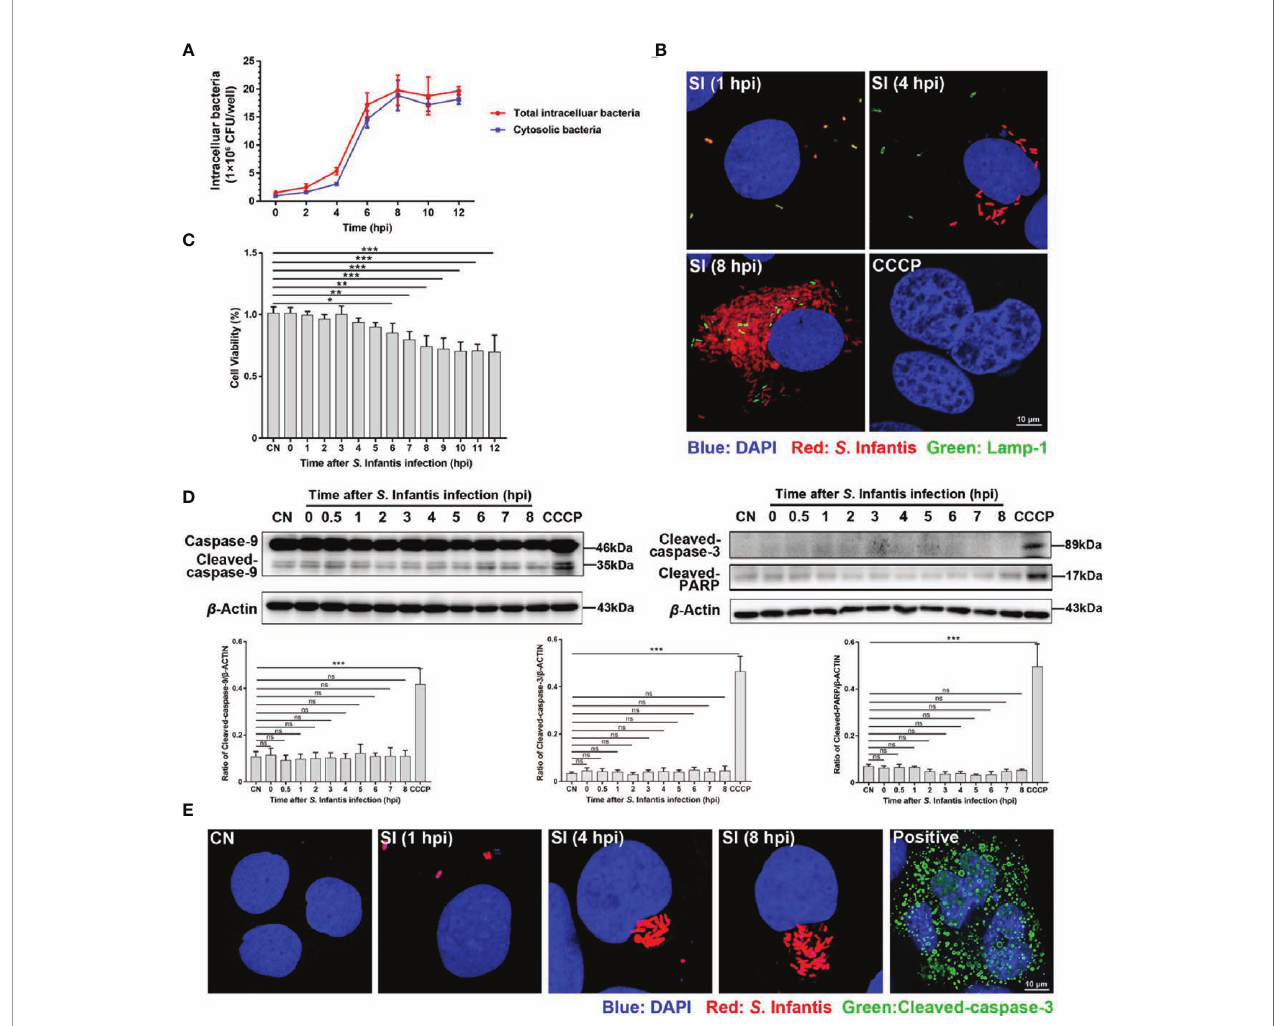
FIGURE 1 | Infected cells containing hyper-replicating cytosolic S . Infantis did not undergo apoptosis. (A) Detection of intracellular bacterial load using the gentamicin protection assay, without (total intracellular bacteria, red curve) or with (cytosolic bacteria, blue curve) chloroquine. Data were obtained from three independent replicates of each sample at 0, 2, 4, 6, 8, 10, and 12 hpi. (B) Detection of the distribution and proportion of two subpopulations in Caco-2 cells by immuno fl uorescence staining. SI, S . Infantis. Red: Salmonella . Green: Lamp-1. Blue: DAPI. Scale bar, 10 µm. (C) Cell viability assay of Caco-2 cells infected with S . Infantis within 12 h. CN, control. (D) Western blot analysis of Caspase-9, Cleaved-caspase-3, and Cleaved-PARP protein expression levels within 12 h after bacterial infection. A total of 10 time points were set for sampling: 0, 0.5, 1, 2, 3, 4, 5, 6, 7, 8 hpi. CN, control. ns, no signi fi cant difference. (E) Immuno fl uorescence staining analysis of Cleaved-caspase-3 in Caco-2 cells. Samples were treated at 1, 4, and 8 hpi, respectively. CN, control; SI, S . Infantis. Red: S . Infantis. Green: Cleaved- caspase-3. Blue: DAPI. Scale bar, 10 µm. CCCP was the apoptosis-positive control group. Data were presented as the mean ± SEM from three independent experiments (n = 3). * P < 0.05, ** P < 0.01, *** P <